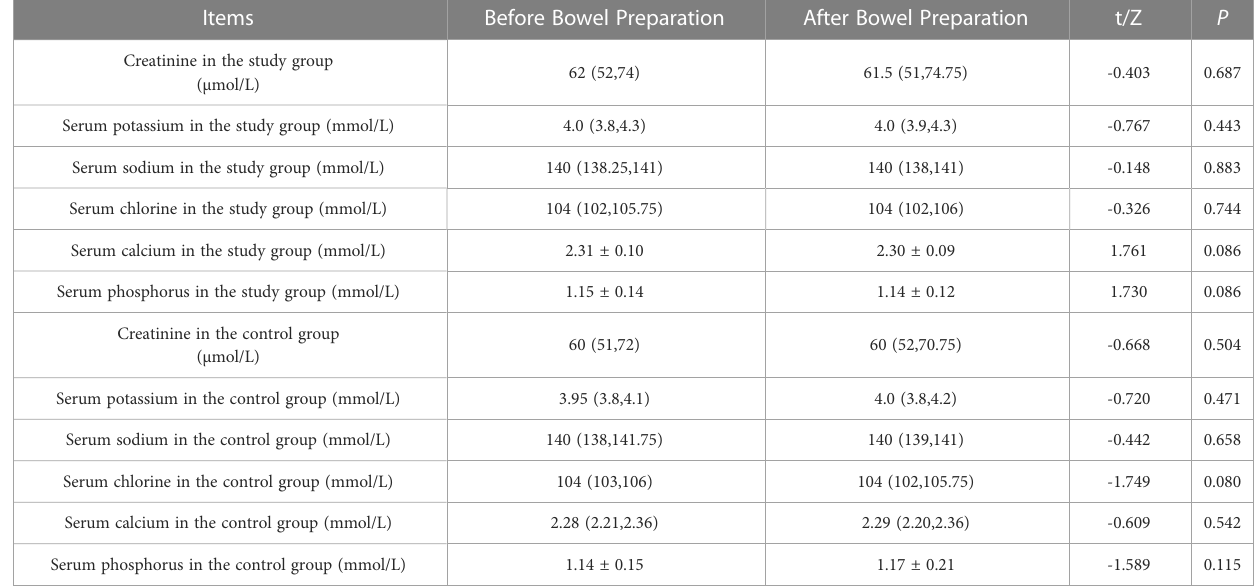
TABLE 7 Changes in renal function and electrolytes before and after bowel preparation between the two groups [(-x ± s), M (25%-75%)]. Items Before Bowel Preparation After Bowel Preparation t/Z P Creatinine in the study group (µmol/L)